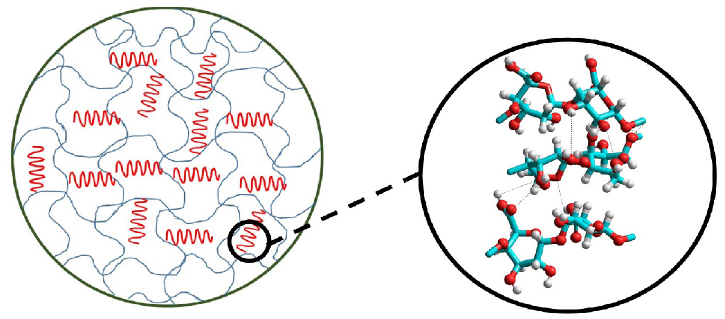
Figure 5. Schematic representation of the interaction between cellulose nanofibrils (CNF) and alginate matrix.